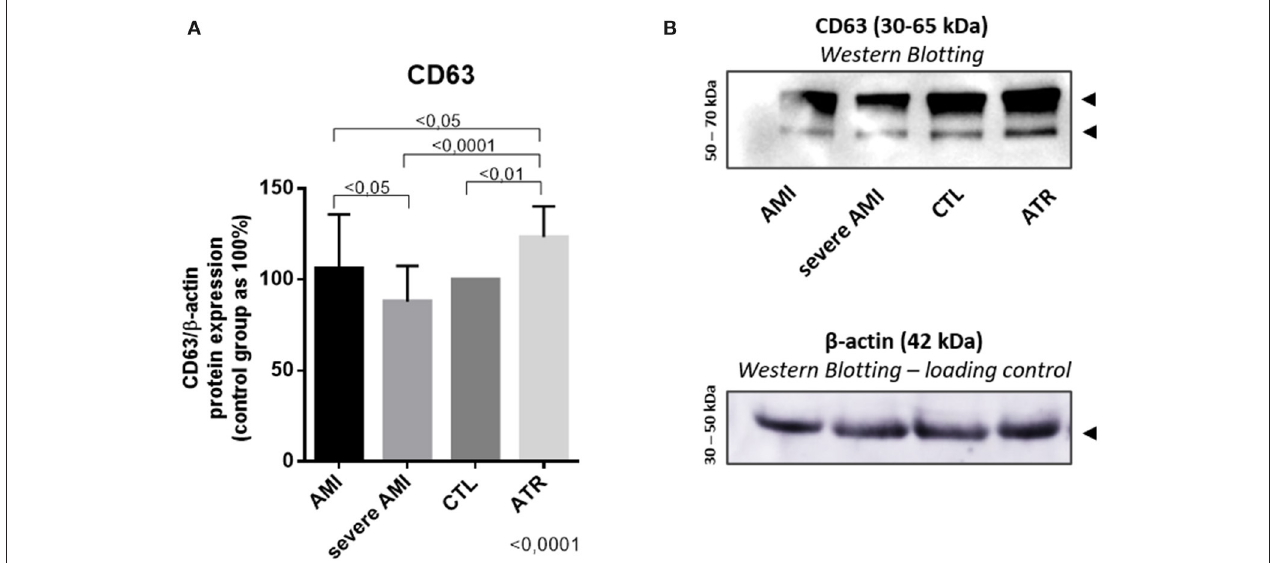
FIGURE 3 | Separation method validation—CD63 exosome specific marker. CD63 protein expression are positively modulated in patients with better prognosis (A) Quantification of CD63 levels (%), with the control group set to 100% ( n = 34. per group). (B) Representative gel of CD63 in the study groups. β -actin is used as a loading control. (Data are expressed as the mean ± standard deviation). Comparison by ANOVA with Tukey applied as a post-test.